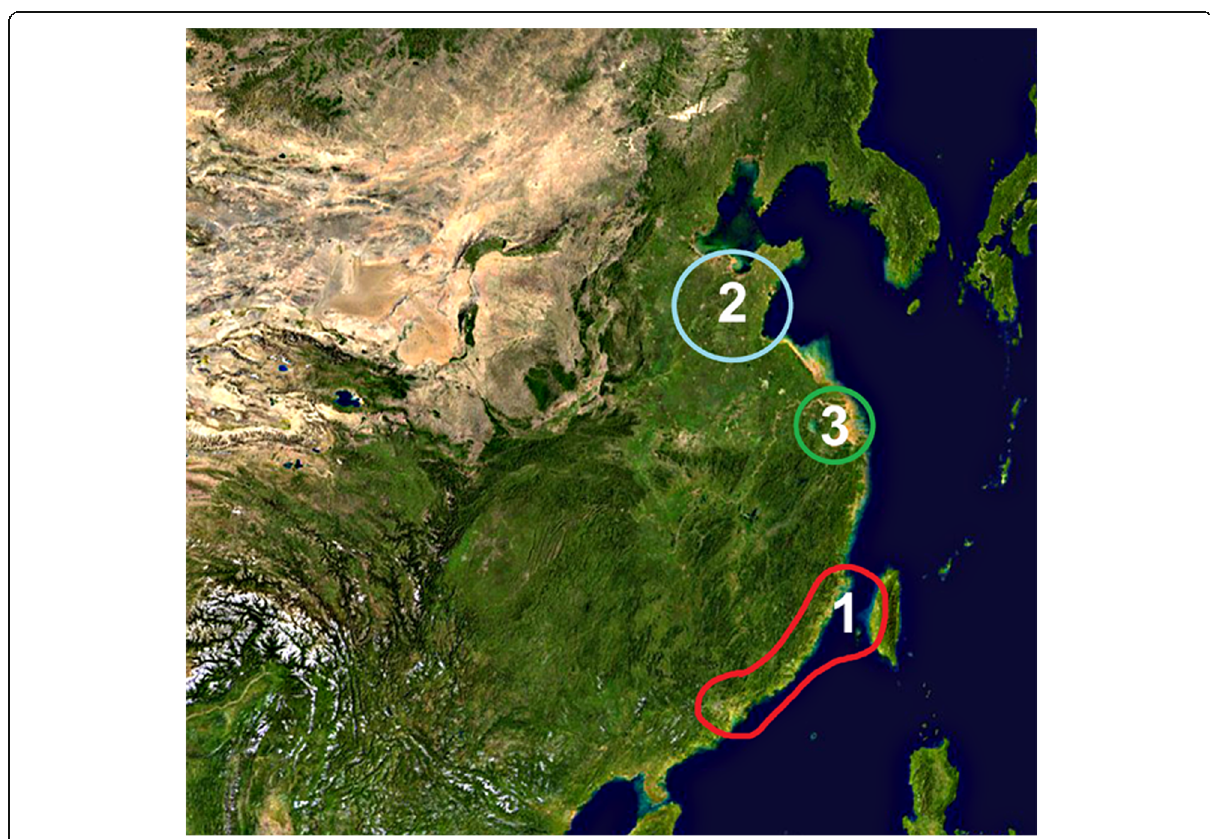
Fig. 1 Mainland origins of the Taiwanese Neolithic according to three models. Blue: Northeastern Seaboard (NES, 2); green: Lower Yangtze (LY, 3); red: Chinese interaction sphere (CIS, 1). The northeastern Asia image was downloaded from https://commons.wikimedia.org/wiki/File:Asia_satellite_ orthographic.jpg originally from